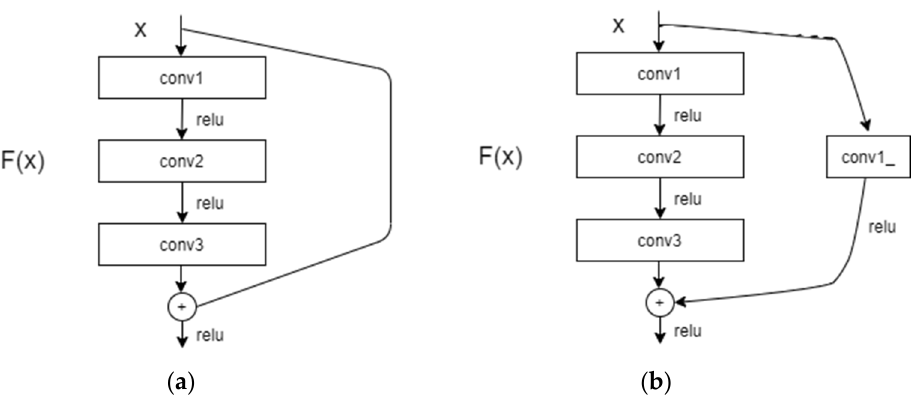
Figure 4. Two residual units used in this study ( a , b ).